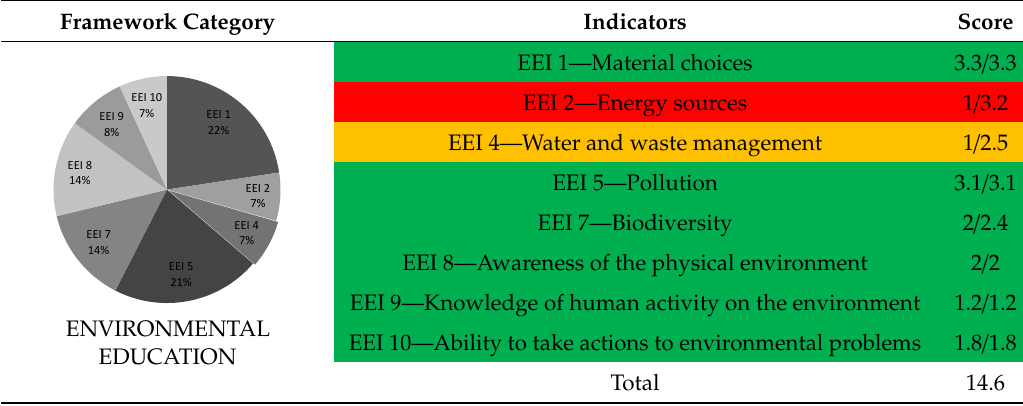
Table 9. RAG rating of Environmental Education Indicator in Louroujina.